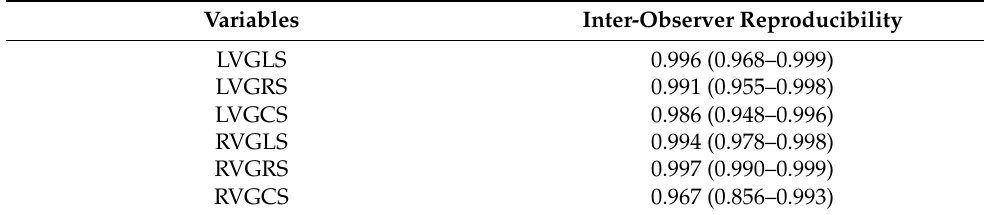
Table 8. Reproducibility of data using intraclass correlation